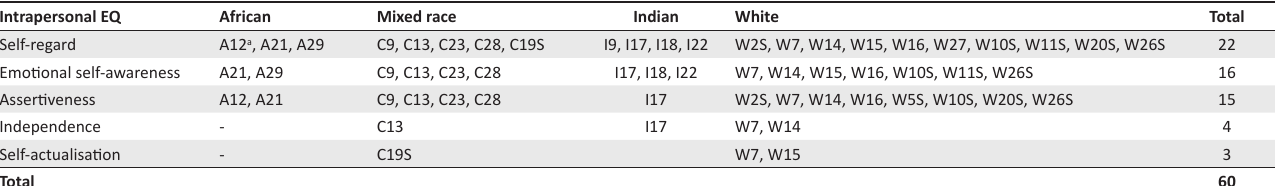
TABLE 6: Intrapersonal EQ. Intrapersonal EQ